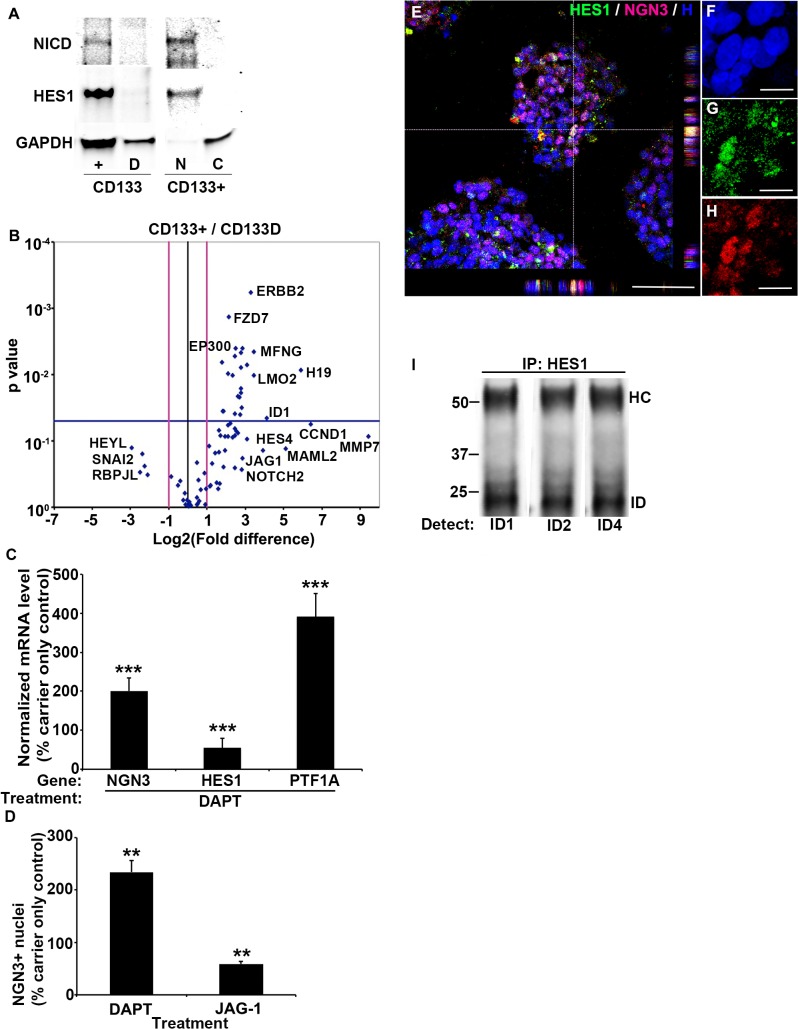
Expression of Notch pathways genes.
A, Western blot analyses of Notch intercellular domain (NICD), hairy enhancer of split 1 (HES1) and endogenous control gene glyceraldehyde-3-phosphate dehydrogenase (GAPDH) in cells isolated from human exocrine tissue. Whole cell lysates from CD133+ (+) and CD133-depleted (D) cells. Nuclear (N) and cytoplasmic (C) extracts from CD133+ cells. B, Volcano plot of Notch pathway gene mean ± SEM mRNA level (n = 3 exocrine cultures) differences in expression level from CD133+ cells compared to CD133D shown on X-axis as Log2 of fold difference. Significance determined by Student’s t-test shown on Y-axis as p value. Magenta vertical lines mark a 2-fold difference in expression. Blue horizontal line marks the significance cutoff (p<0.05). Selected gene names shown. Genes are: receptor tyrosine-protein kinase erbB-2 (ERBB2), frizzled class receptor 7 (FZD7), E1A binding protein p300 (EP300), MFNG O-fucosylpeptide 3-beta-N-acetylglucosaminyltransferase (MFNG), H19, imprinted maternally expressed transcript (H19), LIM domain only 2 (rhombotin-like 1) (LMO2), inhibitor of DNA binding 1 (ID1), hairy enhancer of split 4 (HES4), cyclin D1 (CCND1), matrix metallopeptidase 7 (MMP7), mastermind-like 2 (MAML2), jagged 1 (JAG1), Notch 2 (NOTCH2), hes-related family bHLH transcription factor with YRPW motif-like (HEYL), snail family zinc finger 2 (SNAI2), recombination signal binding protein for immunoglobulin kappa J region-like (RBPJL). C, Normalized mRNA expression level of neurogenin 3 (NGN3), HES1 and pancreas transcription factor 1 subunit alpha (PTF1A) in exocrine tissue after 4 days of culture in the presence of 20 μM Notch inhibitor DAPT. Results reported as mean ± SEM percent of levels in DMSO carrier control. mRNA levels normalized to the level of cyclophillin A. Significance determined by Student’s t-test, ***, p<0.001 (n = 3 exocrine cultures). D, Expression of NGN3 protein following treatment with 20 ∞M DAPT and 47 ∞M Notch agonist JAG-1 peptide (JAG-1). Mean ± SEM percent of DMSO carrier only control or 47 ∞M scrambled JAG-1 peptide, respectively indicated on Y-Axis. Significance determined by Student’s t-test, ***, p<0.001 (n = 3 exocrine cultures). E-H, Orthogonal analysis of colocalized HES1 and NGN3 in nuclei of exocrine tissue after 4 days of culture. Nuclei counterstained with Hoechst 33342 (H). E, Overlay of 3 channels. 0.5 ∞m confocal section. Scale bar is 50 ∞m. F-H, Higher magnification of crosshair region in all three channels shown at right. Scale bars are 20 ∞m. I, Coprecipitation of ID proteins with HES1. Whole cell lysate from exocrine tissue after 4 days of culture immunoprecipitated with antibody to HES1. ID1, 2 and 4 detected following SDS PAGE and western blotting. Predicted molecular weights of ID proteins (ID) and immunoglobulin heavy chain used for precipitation (HC) shown at right. Molecular weight marker positions shown at left in kDa.